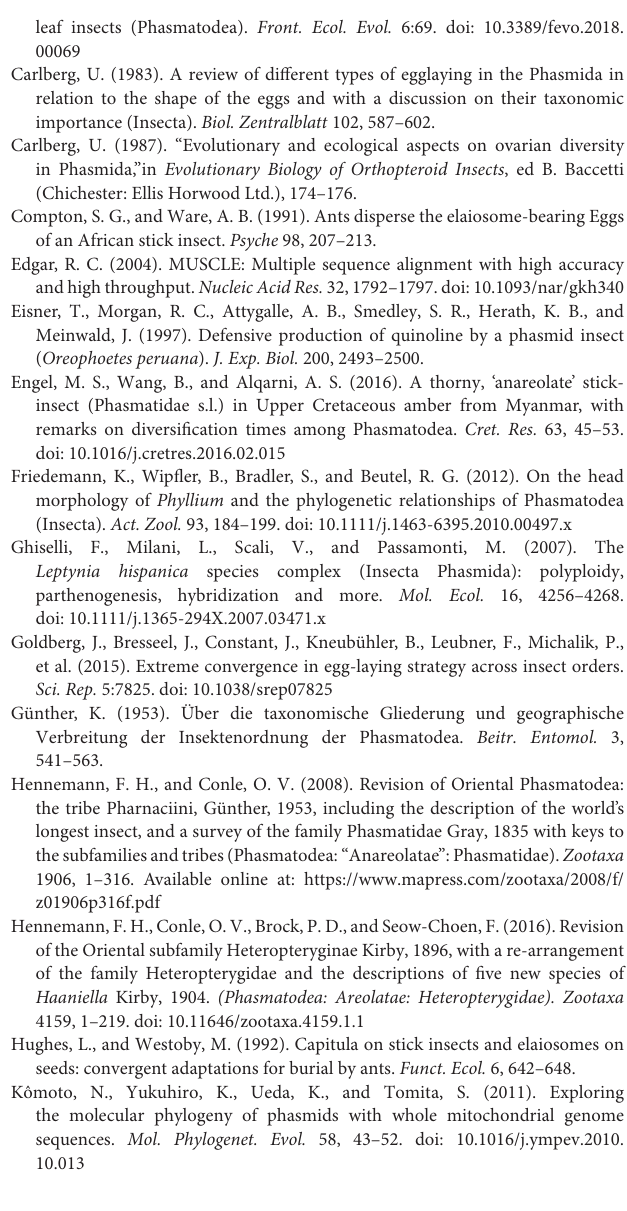
Supplementary Table S3 | Corresponding taxonomic names for the stick and leaf insect eggs pictured in Figure 3 . Supplementary Data Sheet 1 | Nexus input